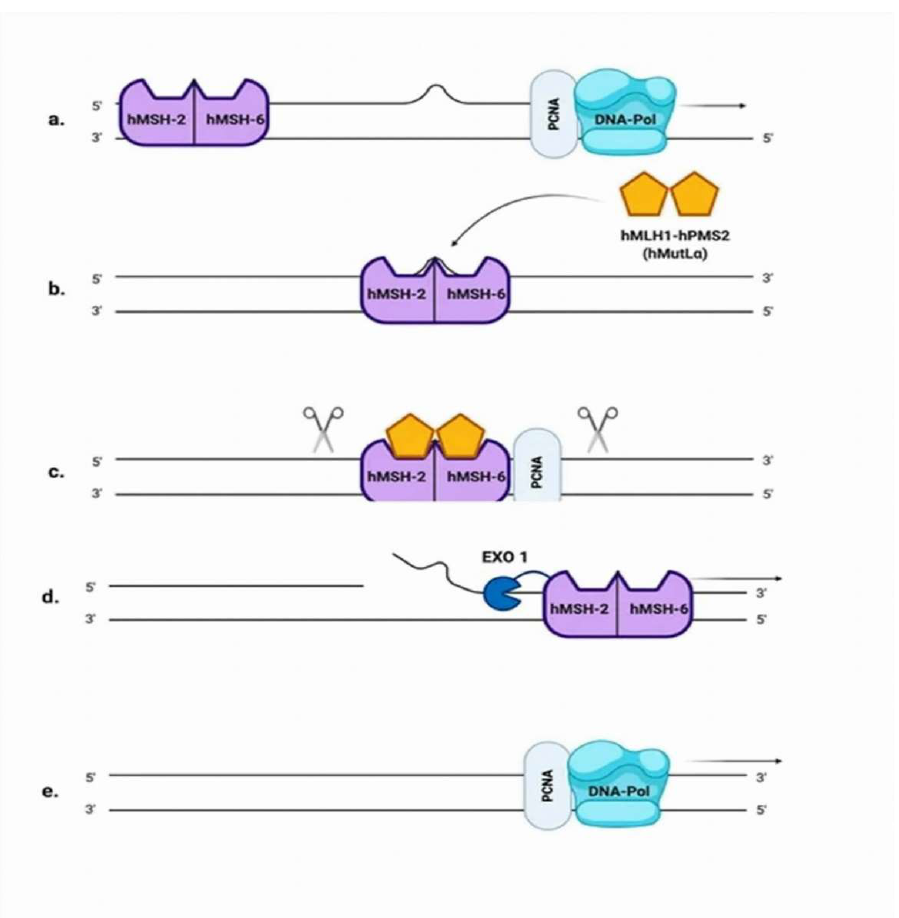
Figure 2. Schematic representation of the mismatch repair (MMR) system. ( a ) MMR enzymes scan the DNA and remove the wrongly incorporated bases from the newly synthesized, non-methylated strand by using the DNA polymerase. ( b ) In MMR, the incorrectly added base is detected after replication by hMutSα, which recruits hMutLα. ( c ) hMutLα detects this base and removes it from the newly synthesized strand. ( d ) hMutSα activates EXO1 and the entire segment of DNA is removed. ( e ) DNA polymerase participates on the replacement of the DNA by correctly paired nucleotides.